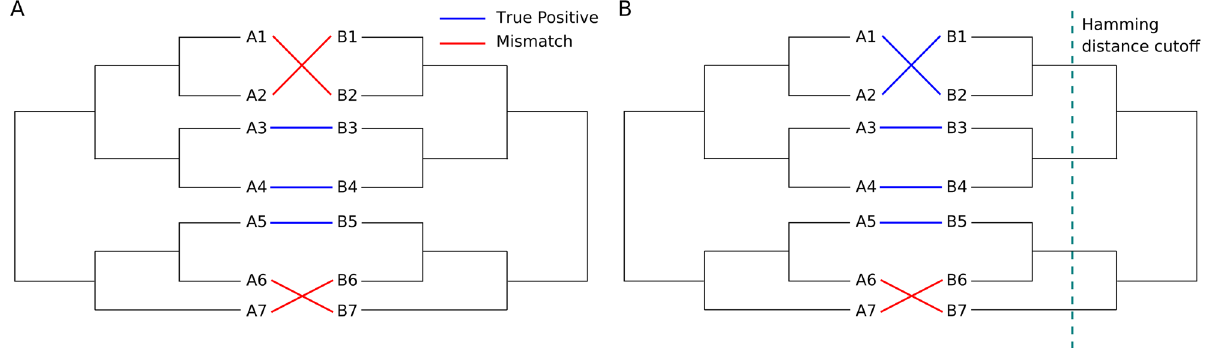
Figure 9. Mismatch discounting based on a Hamming distance cutoff. Scheme showing how the accuracy of the same MSA concatenation would be assessed with ( B ) and without ( A ) mismatch discounting. This figure was created with Inkscape (https:// inksc ape.